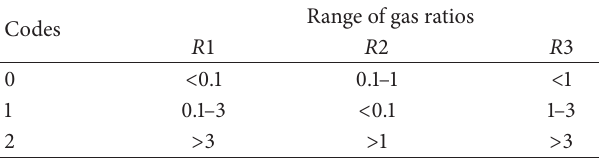
Table 1: Coding rule for IEC method [11].